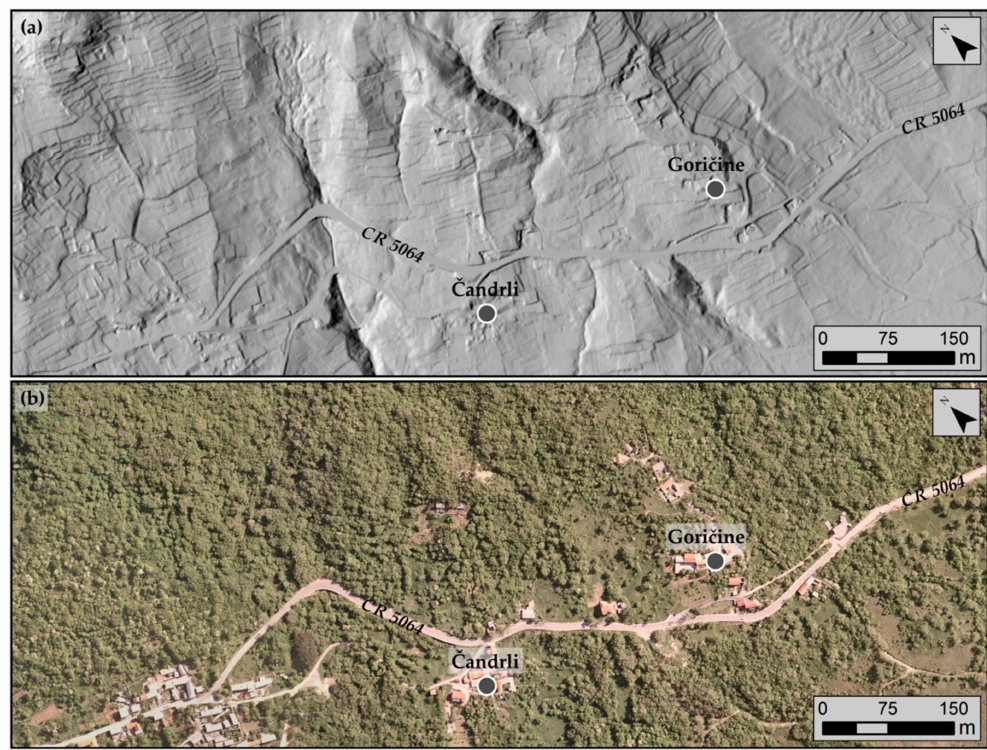
Figure 3. A representative example of topography of the Vinodol Valley shown on: ( a ) the semi-transparent (50%) hillshade map 45 ◦ / 45 ◦ over the hillshade map 315 ◦ / 45 ◦ ; and ( b ) the digital orthophoto map